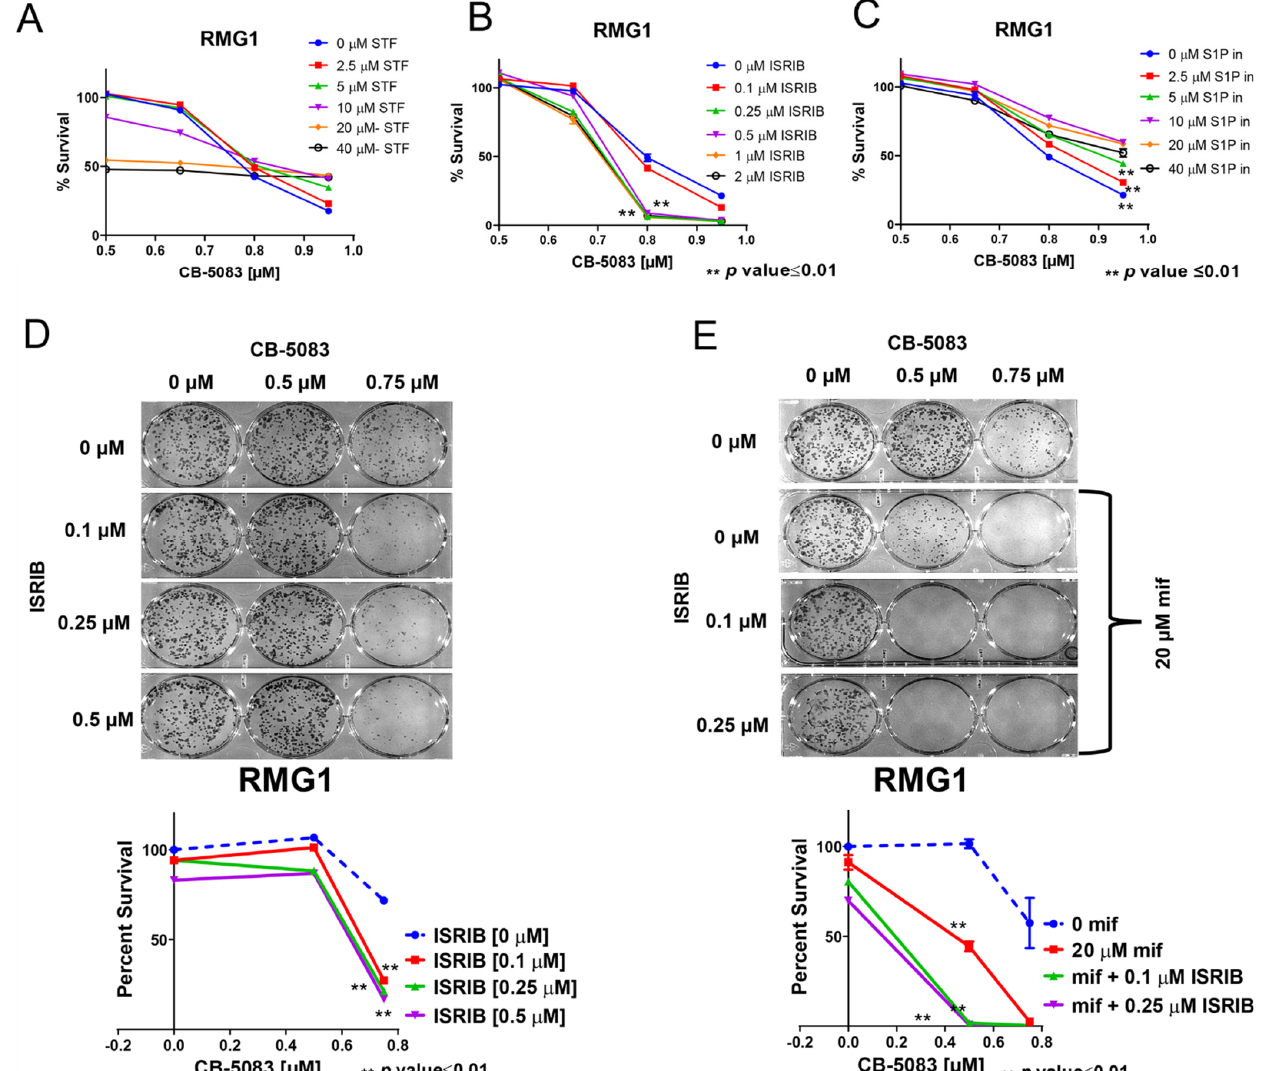
Figure 7. Synergistic drug interactions between CB-5083 and specific ER stress inducers. Dose response to the combination of CB-5083 and an IRE α inhibitor (STF) ( A ), integrated stress response pathway inhibitor (ISRIB) ( B ), or ATF6 pathway inhibitor S1P ( C ) in RMG1 cells. ( D ): Clonogenic combination of CB-5083, ISRIB, and mifepristone. Mean percent survival ± SEM was calculated